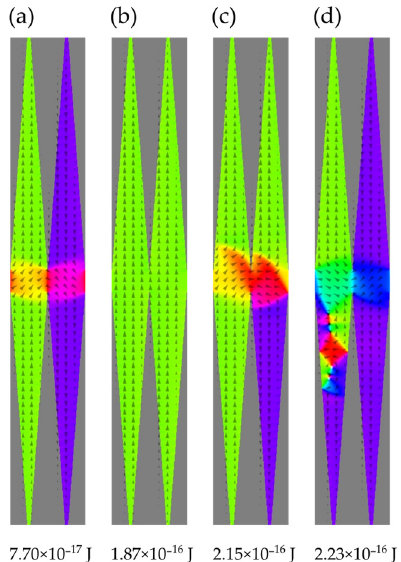
Figure 3. Relaxed magnetization maps for sticking diamonds, i.e., for 𝑑 = 0 obtained at 𝐵 = 0 by starting from ( a ) perfect AF, ( b ) perfect FM, ( c ) with all spins parallel to 𝑥 and ( d ) randomly oriented spins. The total energy of the relaxed configuration is given below each panel.